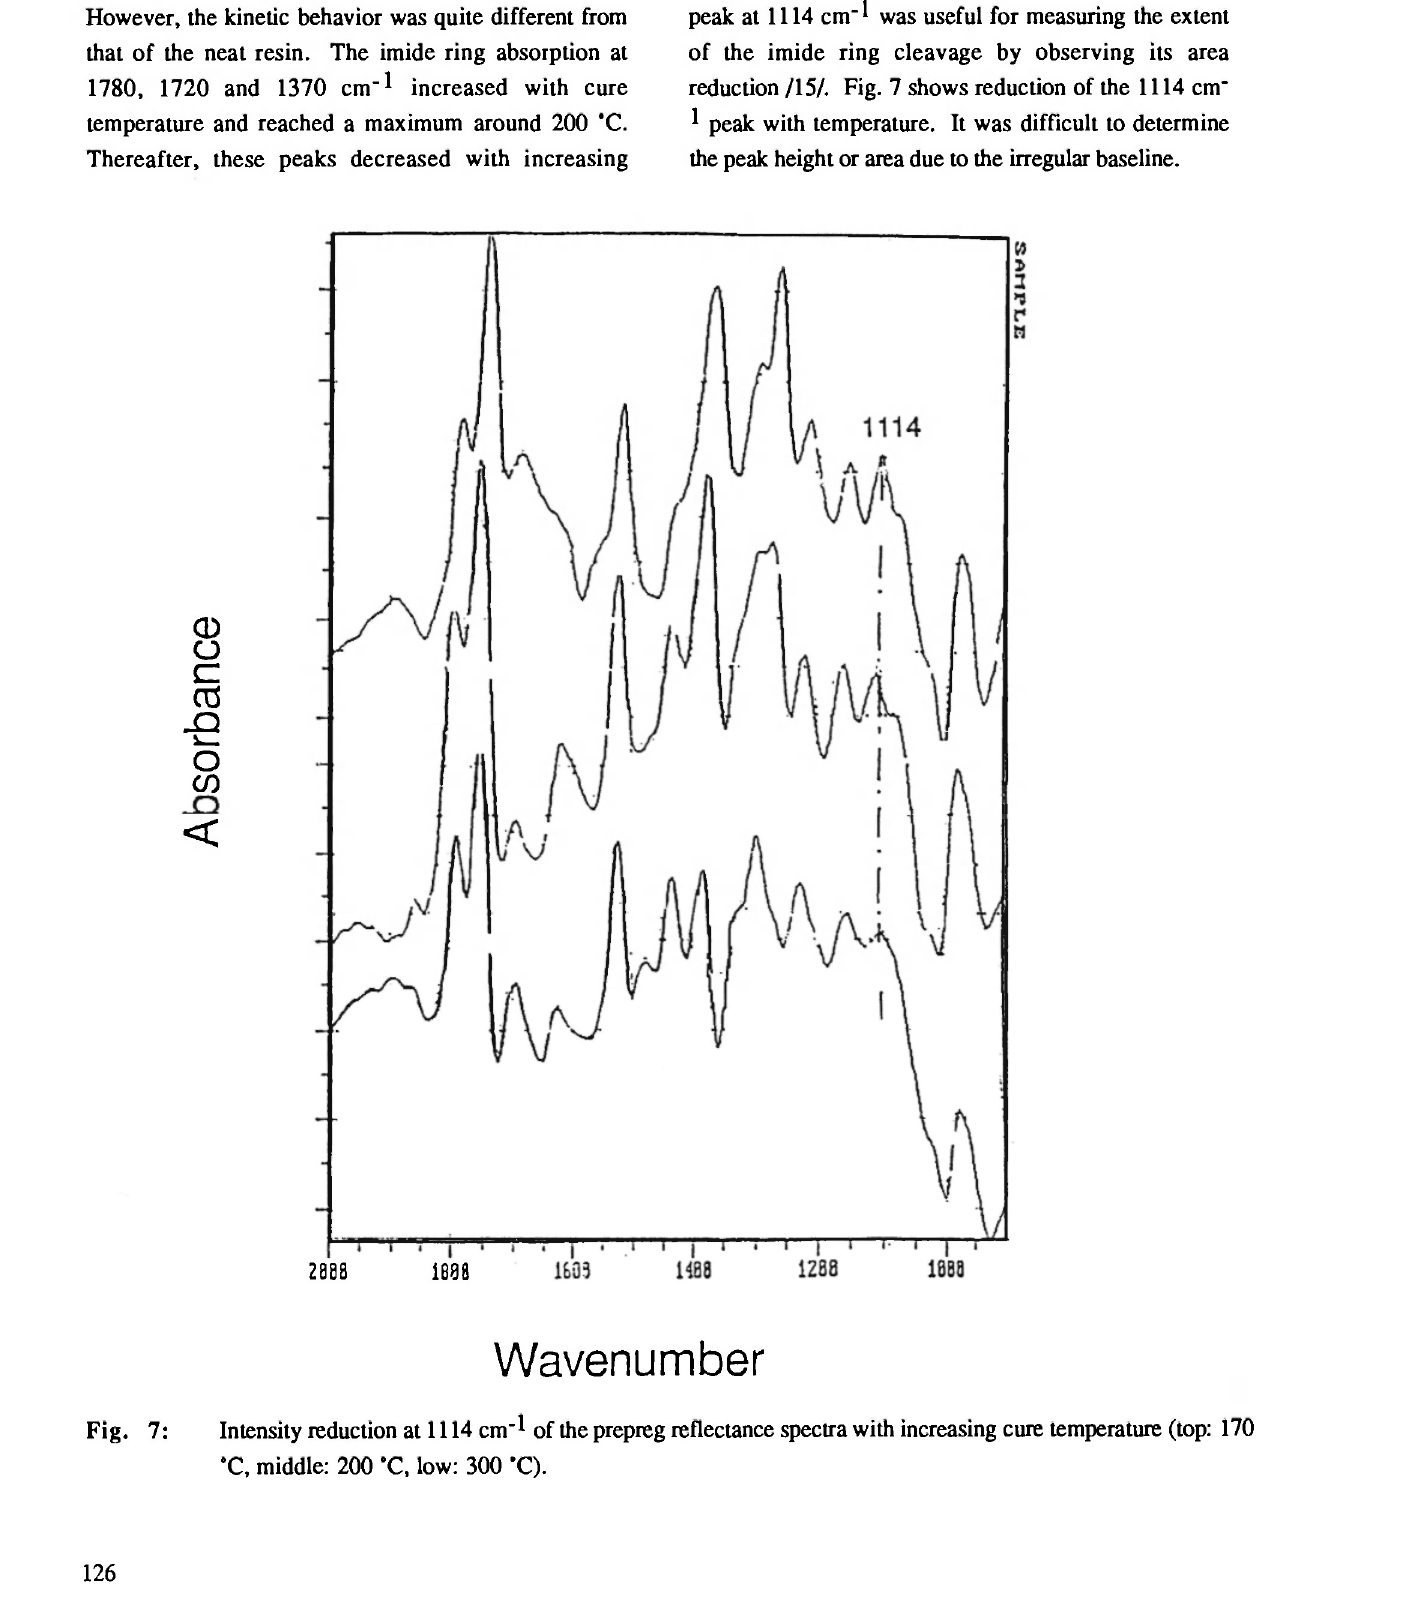
Wavenumber Intensity reduction at 1114 cm"* of the prepreg reflectance spectra with increasing cure temperature (top: 170 °C, middle: 200 °C, low: 300